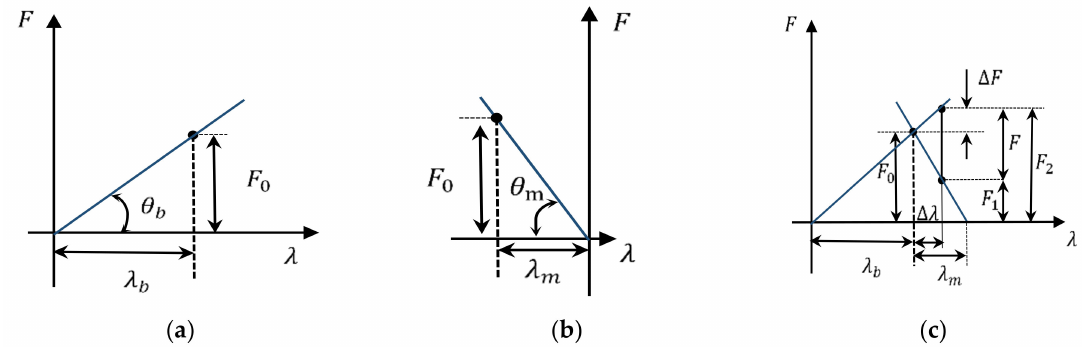
Figure 2. ( a ) The schematic of bolt stiffness; ( b ) The schematic of connector stiffness; ( c ) The relationship between bolt stiffness and connector stiffness.